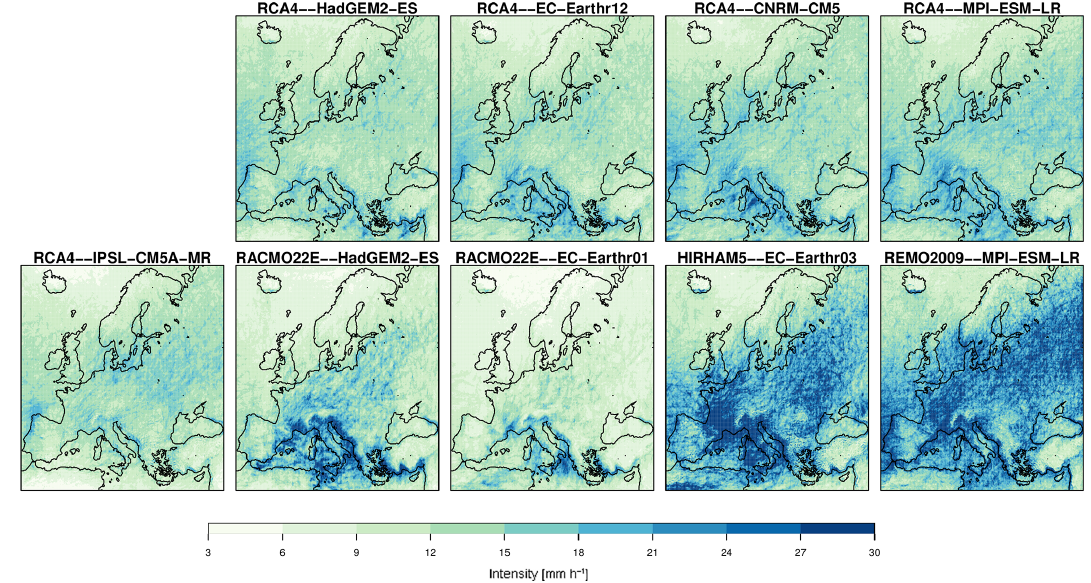
Figure 6. Intensity for 10-year return period for a 1h duration of all models in the RCM